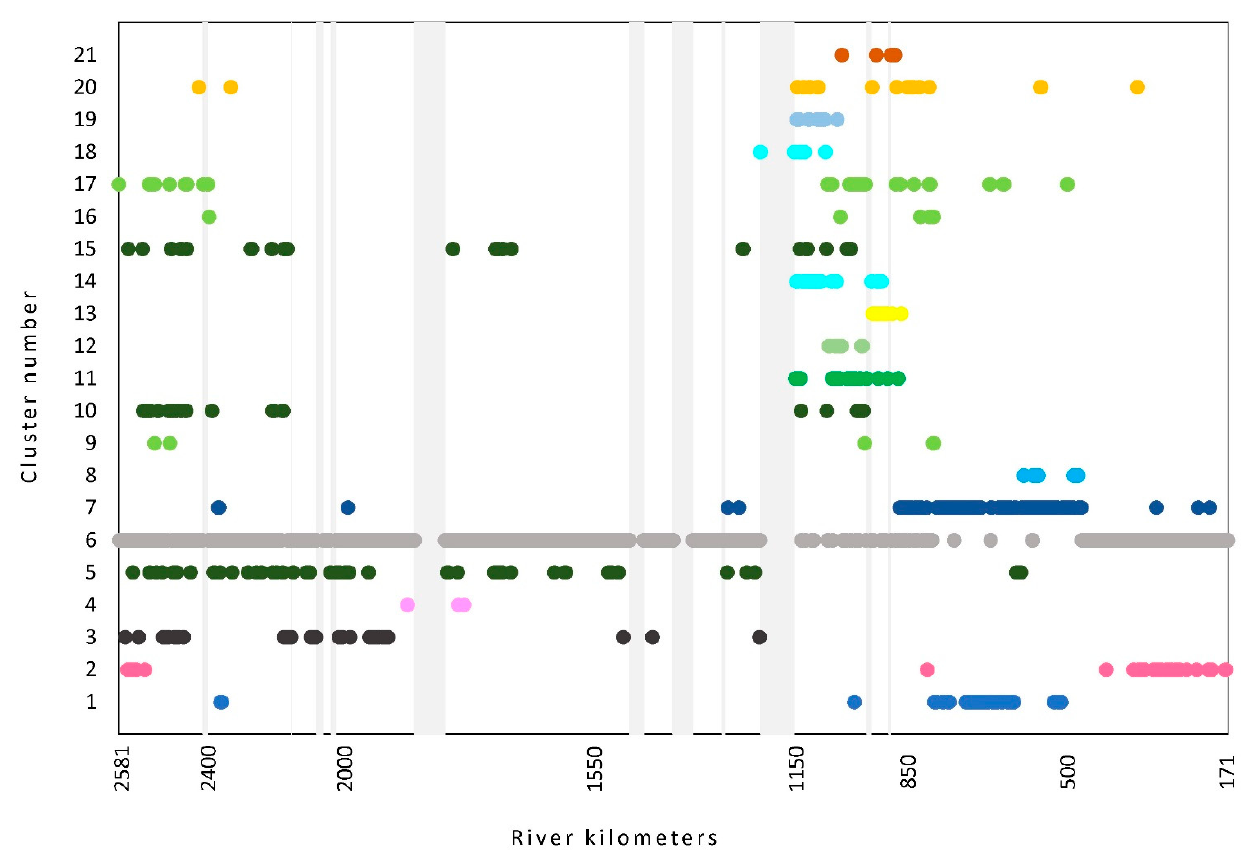
Figure 6. Occurrence of the different clusters along the Danube River flow derived from Figure 5. Different colors indicate different clusters and plant communities (see Table 1). Light gray vertical bars represent sections with no data.